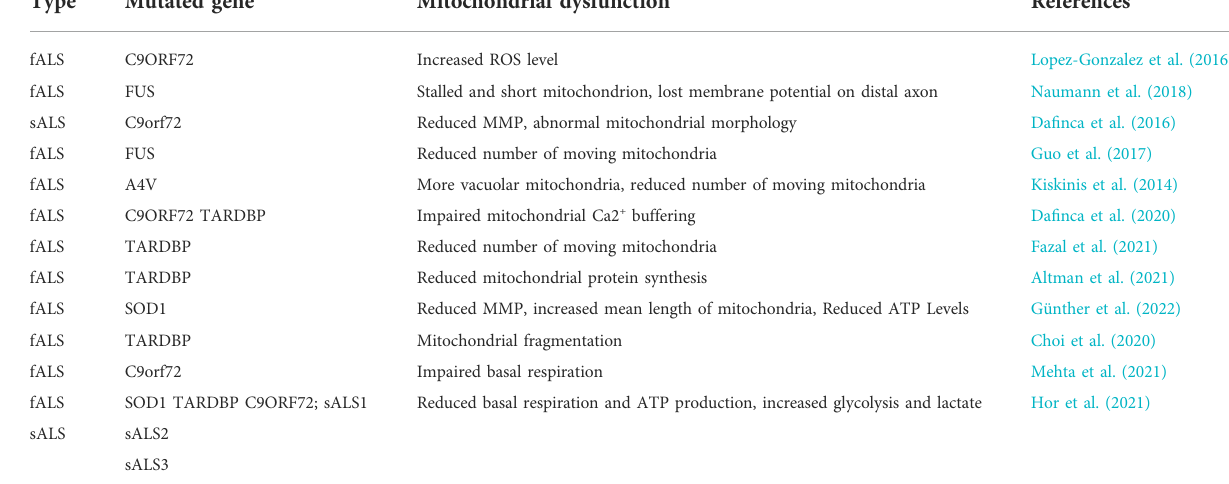
TABLE 4 Mitochondrial dysfunction in iPSC-derived MNs modeling of